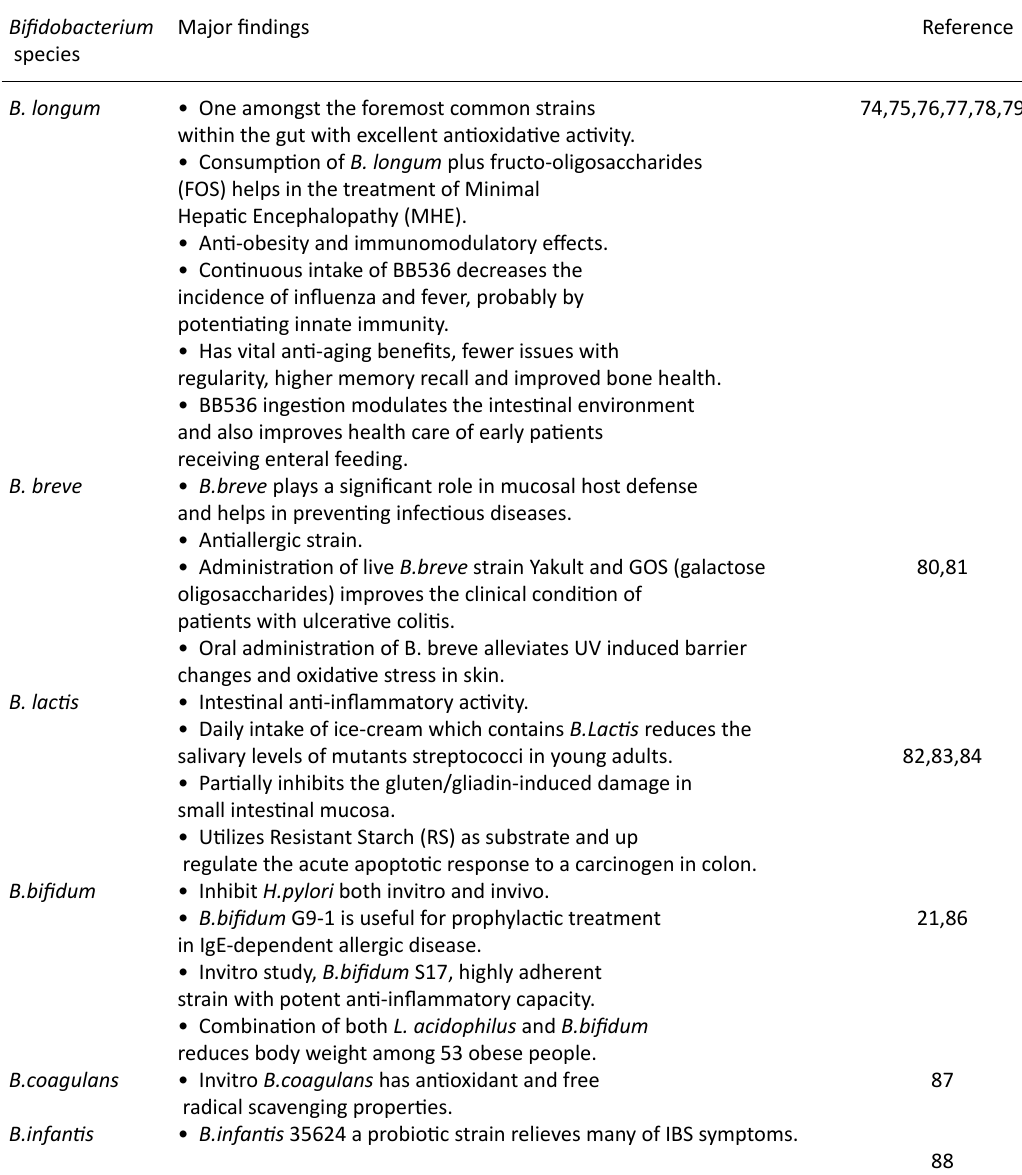
Table 4. Major Findings on Bifidobacterium species Bifidobacterium Major